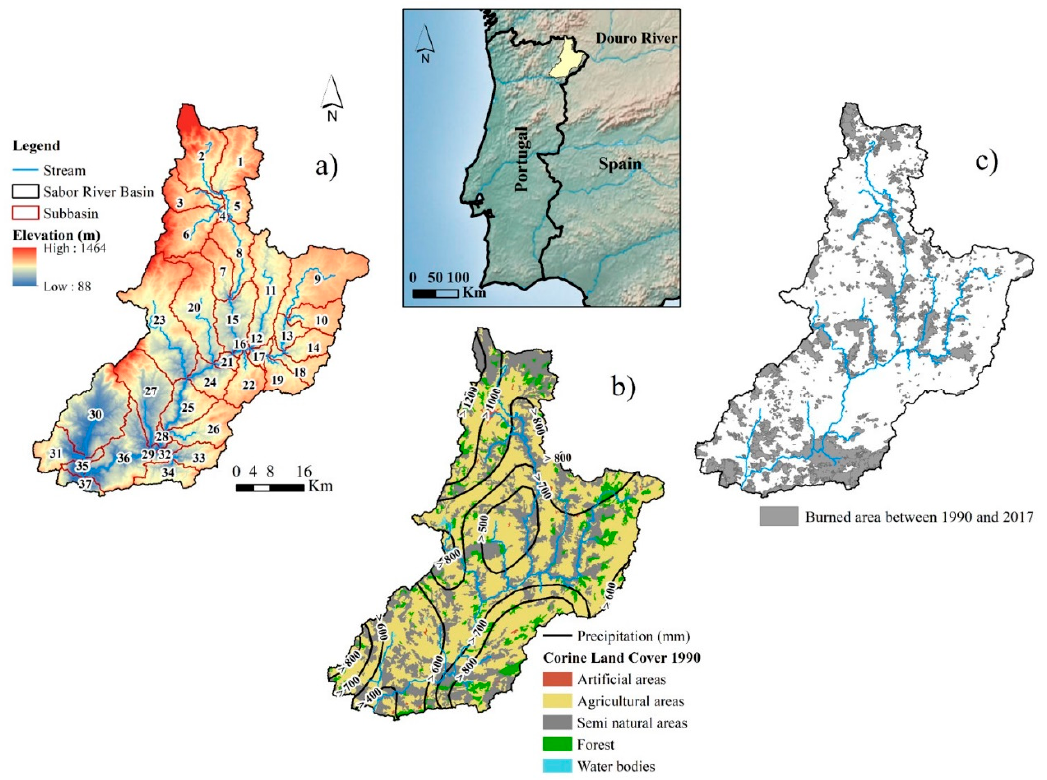
Figure 1. The spatial distribution of ( a ) the drainage network, the topography, and the sub-basins of the Sabor river basin; ( b ) the temperature and the CORINE Land Cover in 1990; and ( c ) the area burned between 1990 and 2017.